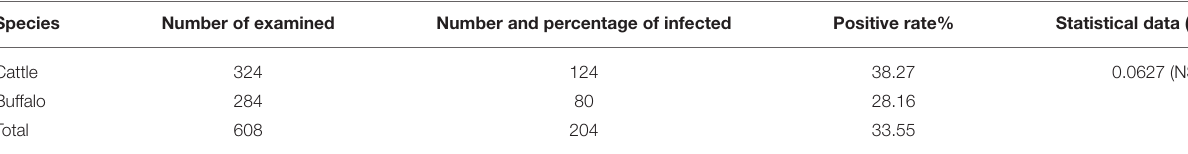
TABLE 3 | Prevalence of Cryptosporidium infection in cattle and buffalo calves.